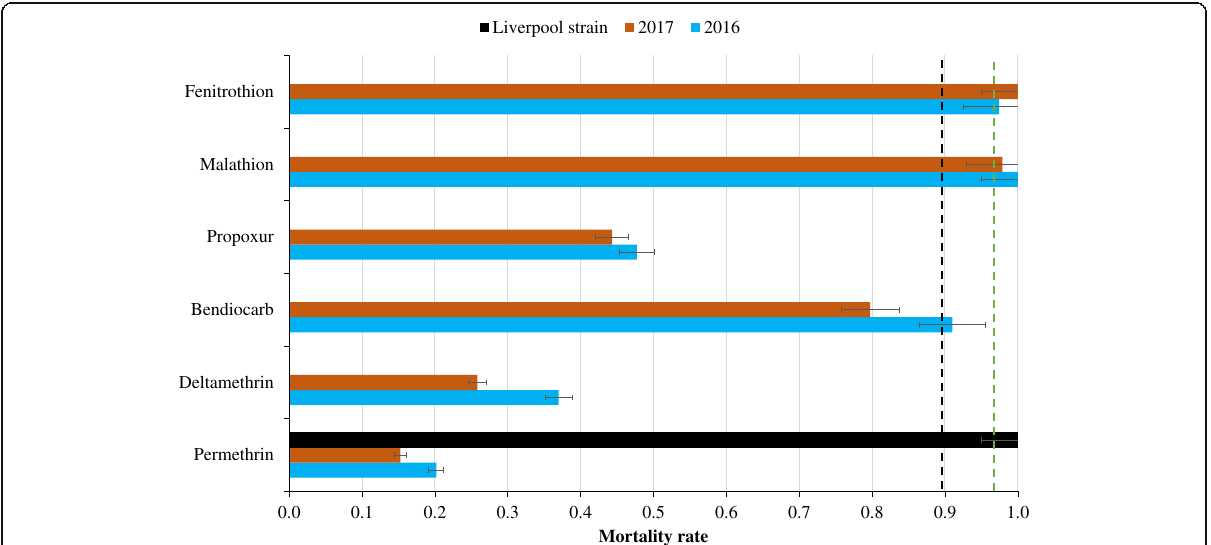
Fig. 1 Mortality (with standard errors) of Ae . aegypti following insecticide exposure in WHO tubes. The green dashed line indicates the threshold for susceptibility, and the black dashed line indicates the threshold for resistance